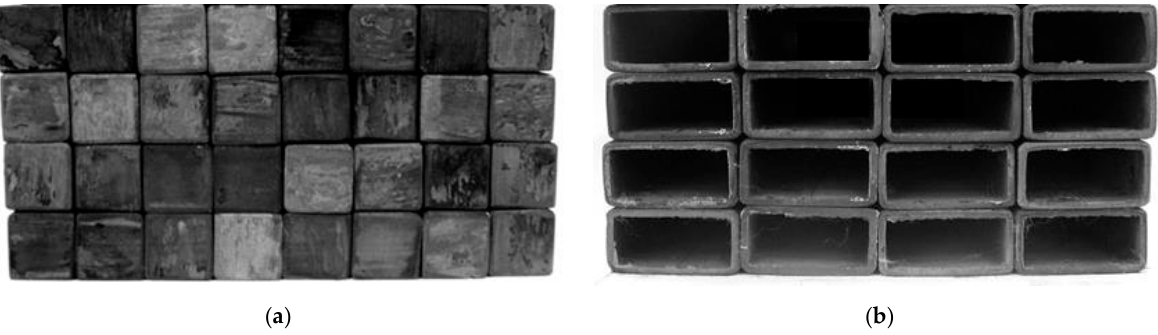
Figure 3. Samples tested in the guarded hot plate apparatus: ( a ) square bars; ( b ) rectangular sec- tions.